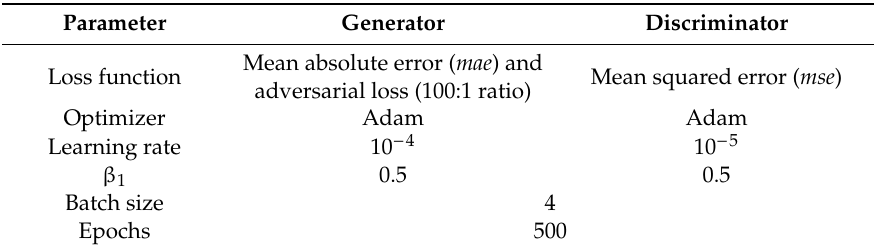
Table 1. Training input parameters for generator and